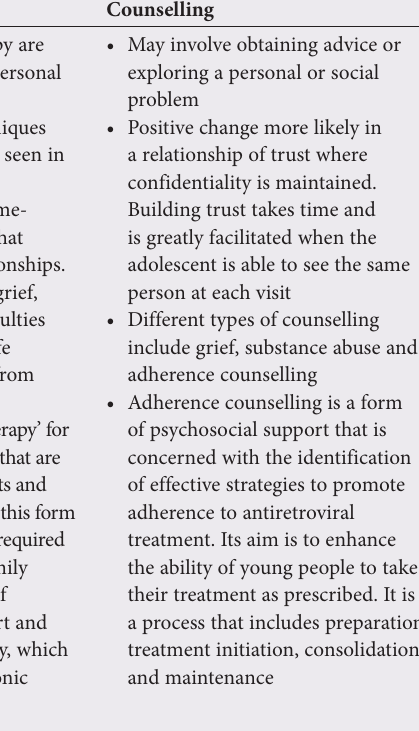
Table 13. Psychosocial interventions for adolescents Support